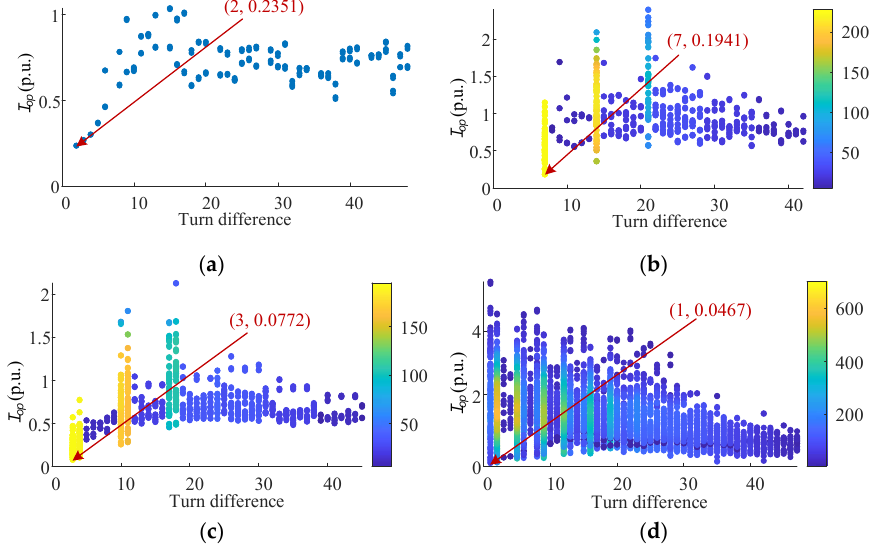
Figure 11. When s = 0.05, the simulation results of all possible internal short ‐ circuit faults in rotor windings: ( a ) in ‐ slot faults; ( b ) end faults in the same branch with different short turns; ( c ) end faults between two branches in the same phase; ( d ) end faults between phases.